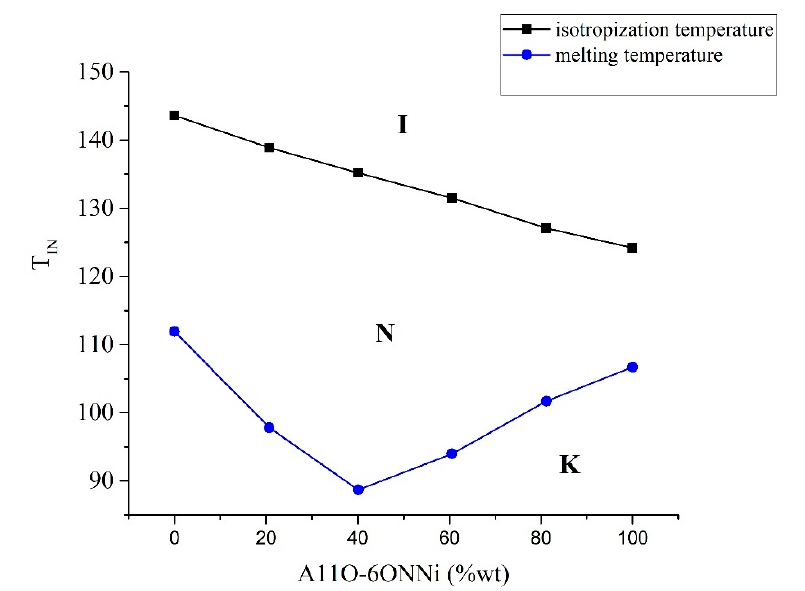
Figure 7. Binary phase diagram for A11O-6ONNi/A11O-6ONPd blends. K indicates the stability field of the crystalline solid phase, N that of the nematic phase and I the isotropic phase. Table 3. Transition temperatures of A11O − 6ONNi/A11O − 6ONPd binary blends. A11O − 6ONNi (%wt.)